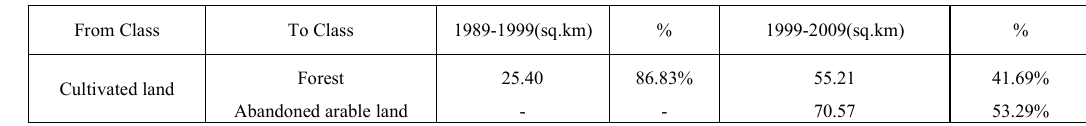
Table 3 The cultivated land conversions 1989-1999 and 1999-2009